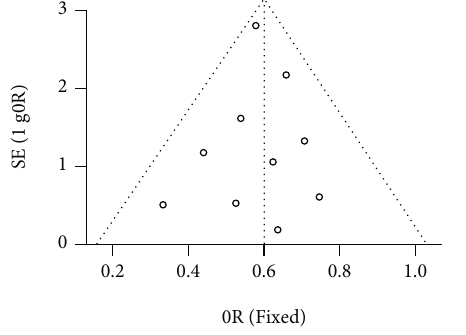
Figure 2: Funnel plot for analysis of publication bias in the included